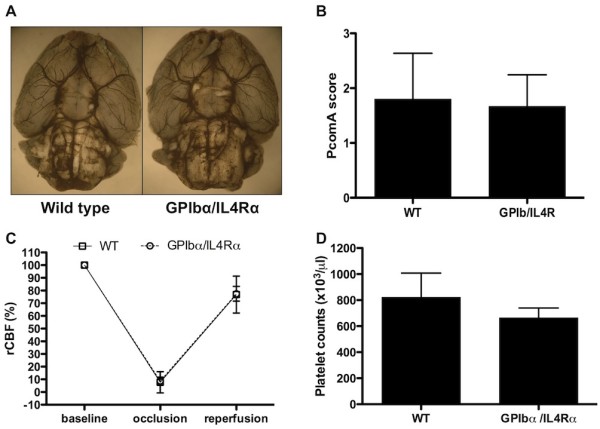
Regional cerebral blood flow and cerebral vasculature in WT and GPIbα/IL4Rα mice. (A) Representative stainings of cerebral vasculature by black ink perfusion of WT and GPIbα/IL4Rα mice. (B) Score assessing the posterior communicating arteries perfusion of WT (n = 5) and GPIbα/IL4Rα mice (n = 3). (C) Regional cerebral blood flow of the right middle cerebral artery territory of WT (n = 5) and GPIbα/IL4Rα mice (n = 3), measured at baseline, during occlusion and 15 min after reperfusion (reperfusion). (D) Platelet counts of WT (n = 9) and GPIbα/IL4Rα mice (n = 6). No statistically significant differences were observed in all parameters (A-D).